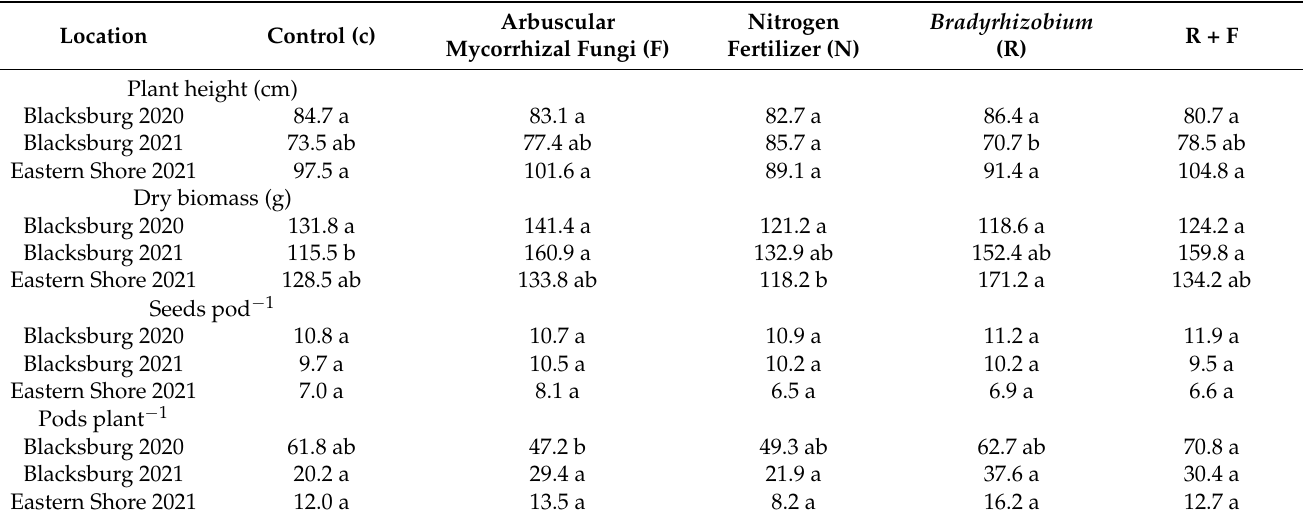
Table 2. Mungbean plant height, dry biomass, seeds per pod, and pods per plant by treatments at Blacksburg 2020, Blacksburg 2021, and Eastern Shore 2021. (n = 225 plants).